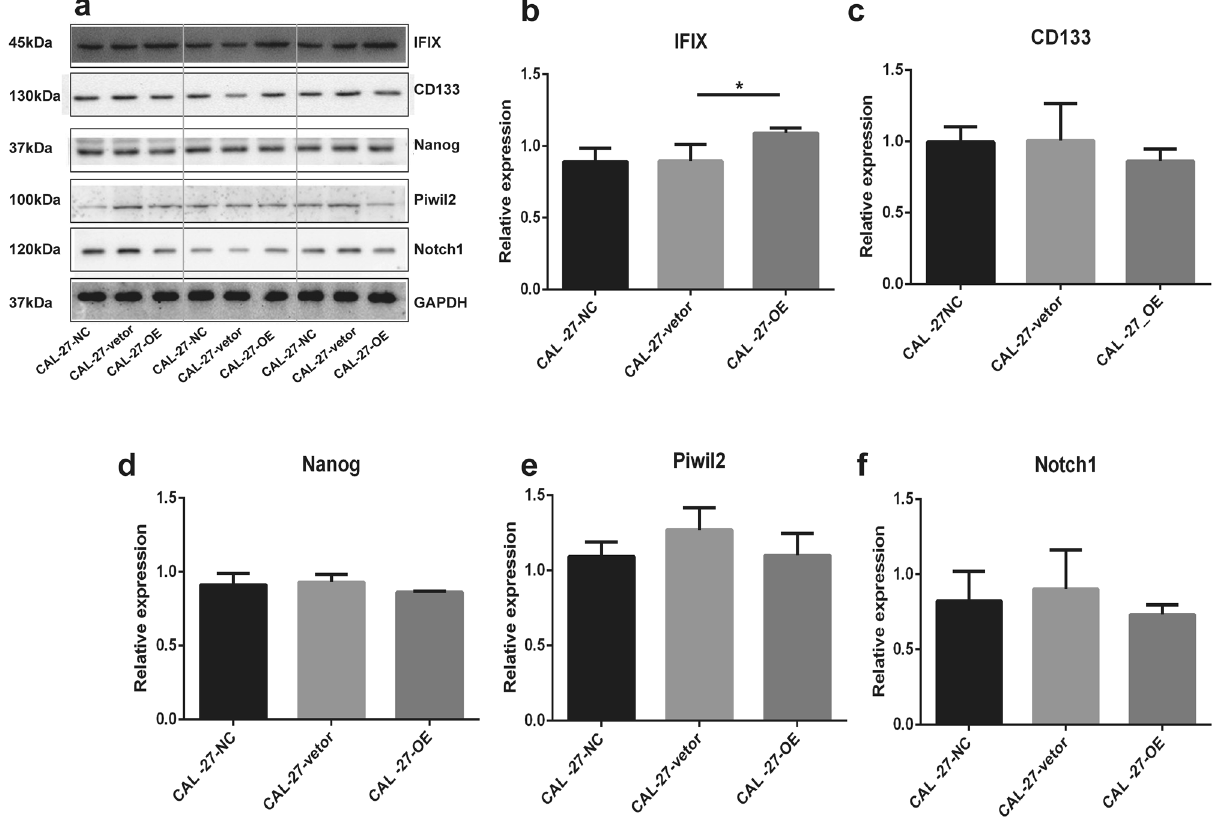
Figure 4. IFIX does not limit the establishment of CSCs. ( a ) Cell lysates were analyzed by western blotting for CD133, NANOG, PIWIL2, and NOTCH1 as general CSC markers in CAL-27 cells infected with the lentivirus overexpressing IFIX (CAL-27-OE), CAL-27 cells infected with the empty lentiviral vector (CAL-27-vector), and CAL-27 normal control cancer cells (CAL-27-NC) Gels and blots were presented by three groups at a time and the blots were cut prior to hybridisation with antibodies during blotting. ( b – f ) The data were replicated twice in one test and presented as the mean ± SD; * P <